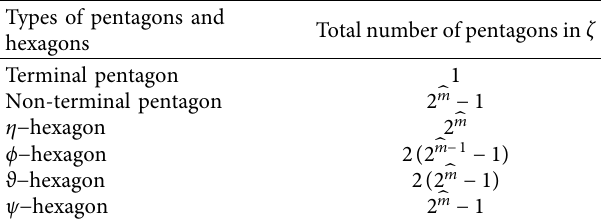
Table 9: Types of pentagons and